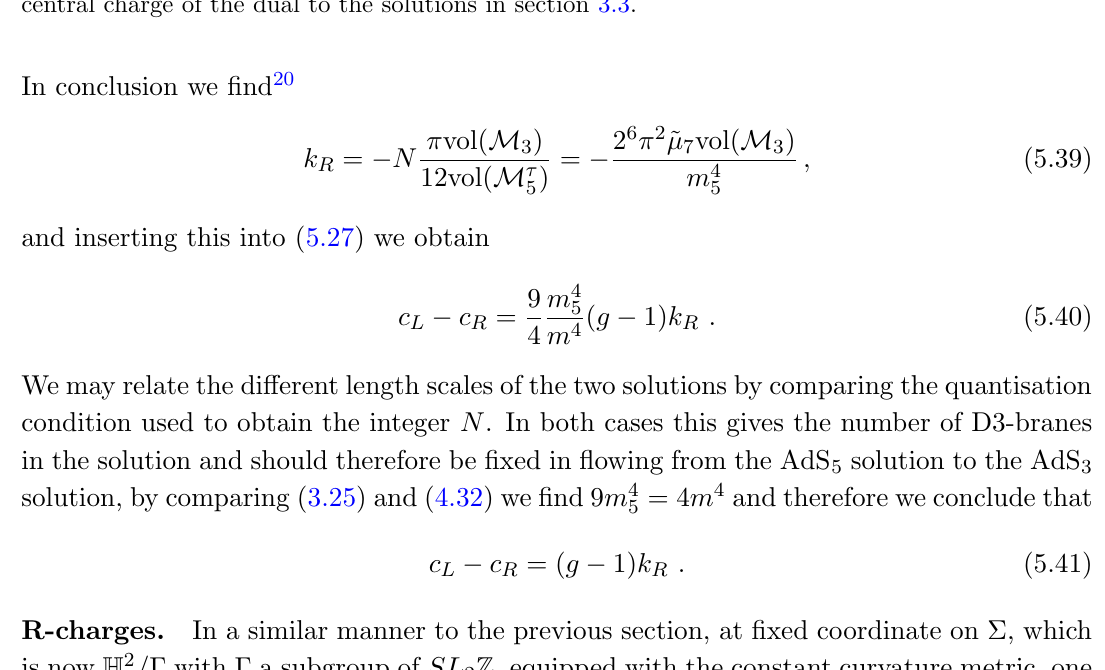
. Here a 4 d is the (cid:28) 6